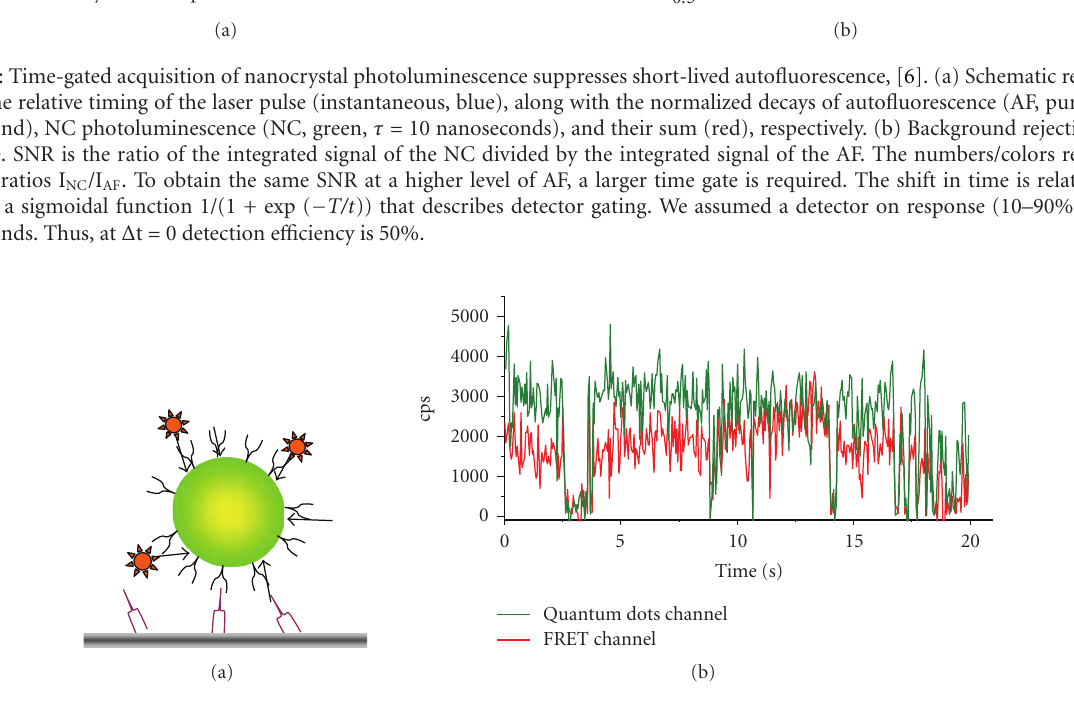
Figure 2: Use of blinking to detect single-particle fluorescence resonance energy transfer (spFRET). (a) Schematic representation of the donor/acceptor geometry consisting of a central QD565-ITK/STV donor (green) and biotinylated Alexa594 acceptor (red). NCs were im- mobilized on glass slides using a biotin-antibody linker. (b) Time-resolved traces of PL intensity simultaneously observed in the donor (D565/20 nm) and FRET channel (D655/40 nm) upon donor 440-nm excitation. The green-emitting NC donor transfers its energy to mul- tiple orange-red fluorescing acceptors. Donor bleed through and acceptor direct excitation are negligible, and contribute less than 0.5% each to the total signal, respectively. Note the concomitant blinking in both channels, indicating no energy transfer when the quantum dot donor is in an OFF state, a hallmark of spFRET [21]. cps = counts per